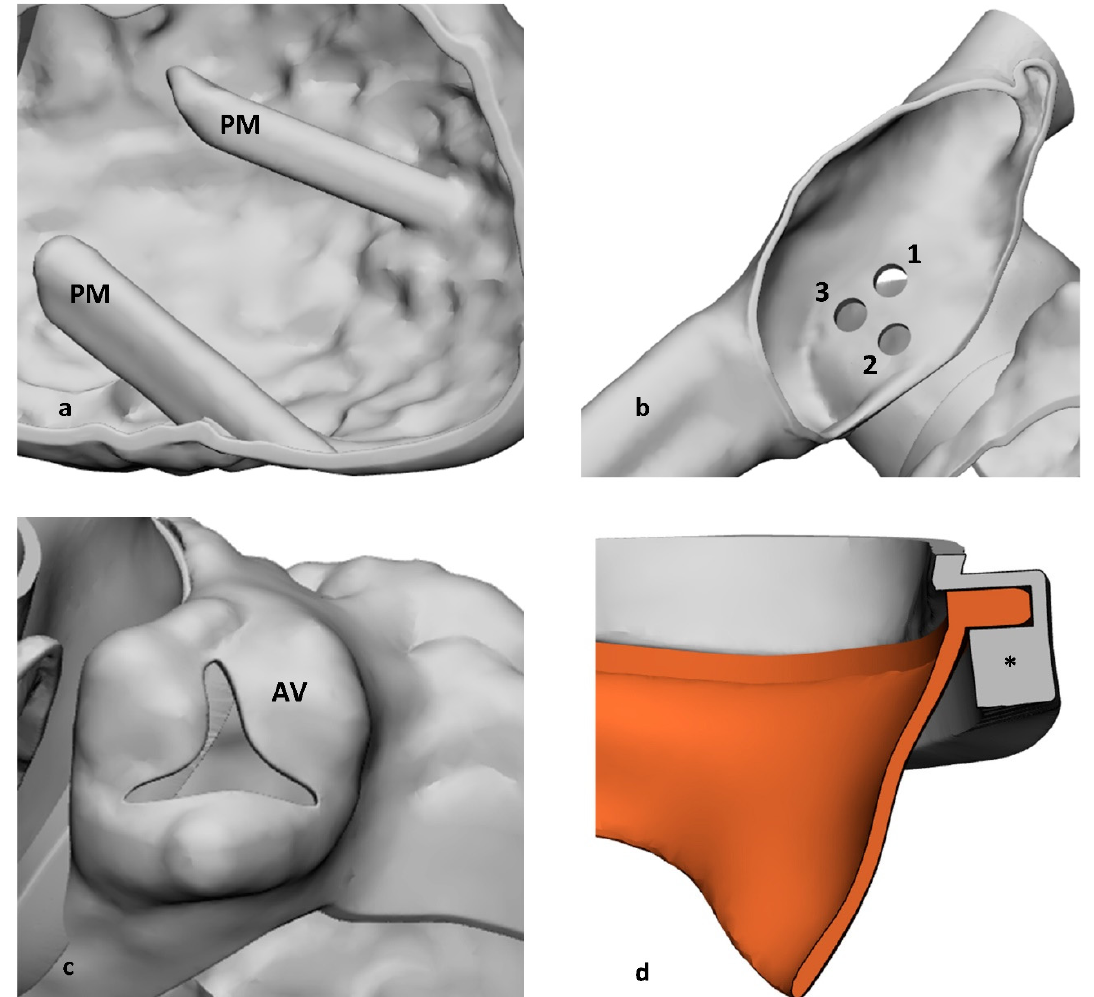
Figure 2. Details of the computed-assisted design modifications of the model. ( a ): Extruded papillary muscles (PM). ( b ): Transseptal holes to practice different approaches of the puncture (1—posterior-superior; 2—anterior-inferior; 3—posterior-inferior). ( c ): Aortic valve (AV). ( d ): Cross sectional view of the modular insertion of the MV annulus (*) and MV leaflets (orange).